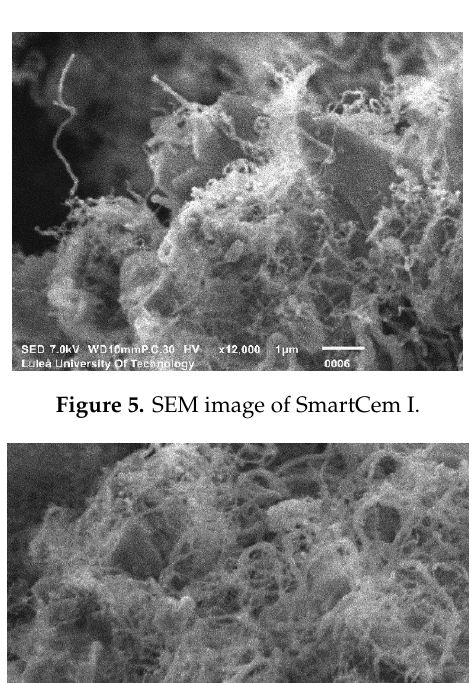
Figure 7. TG Analysis of SmartCem I and SmartCem II.